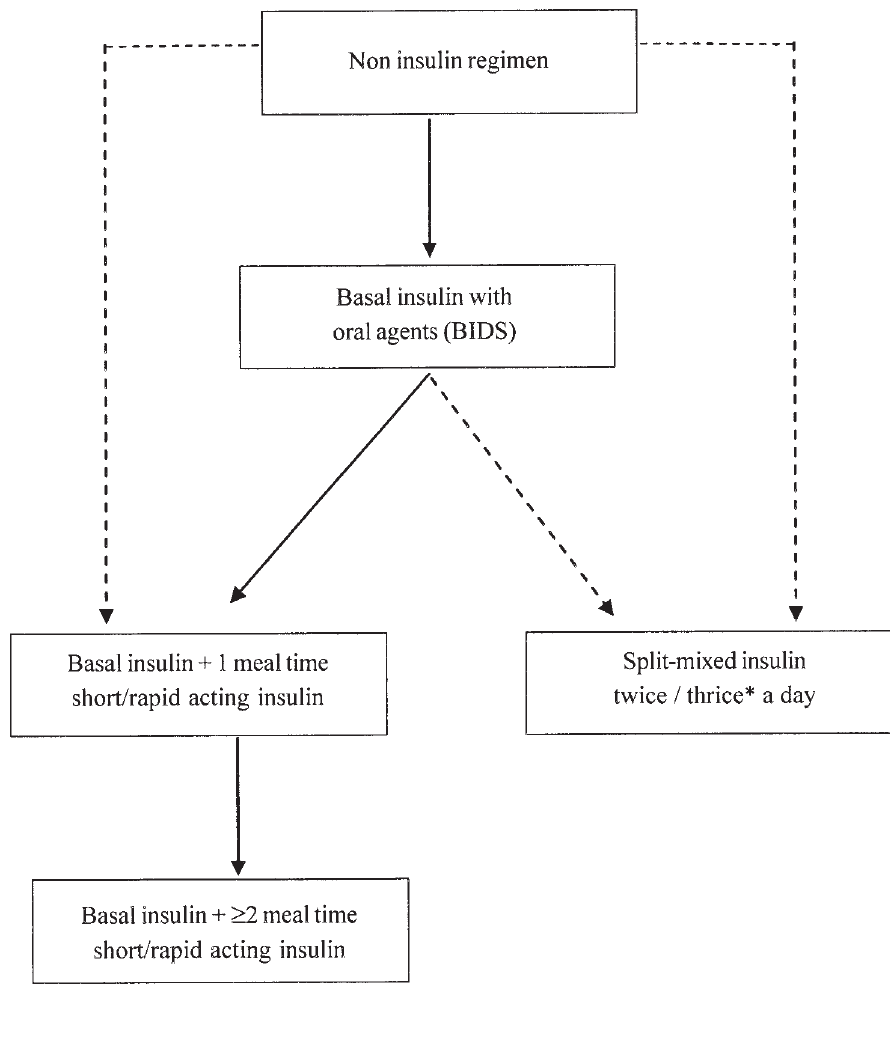
Figure 2. Sequential insulin strategy in type 2